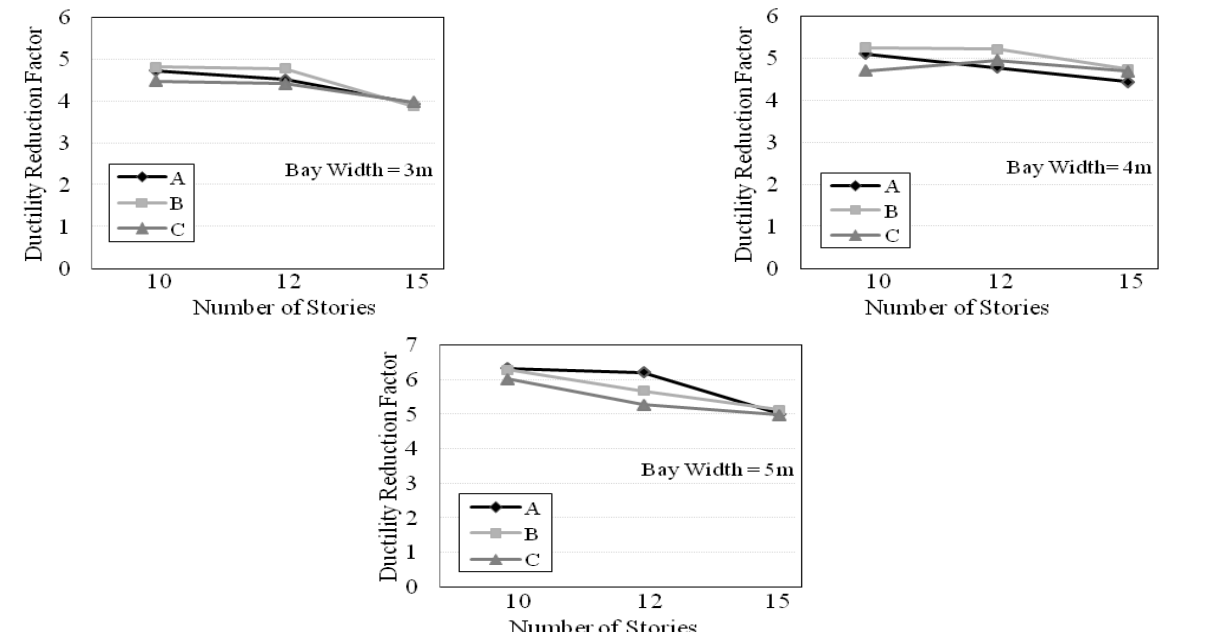
Fig. 5. Variation of ductility reduction factor for different number of stories.